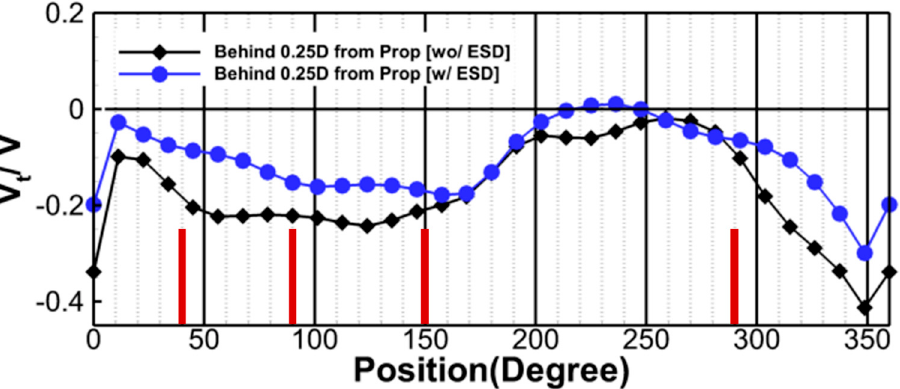
Figure 12. Averaged circumferential tangential velocity component at plane behind 0.25 D from propeller (without propeller).